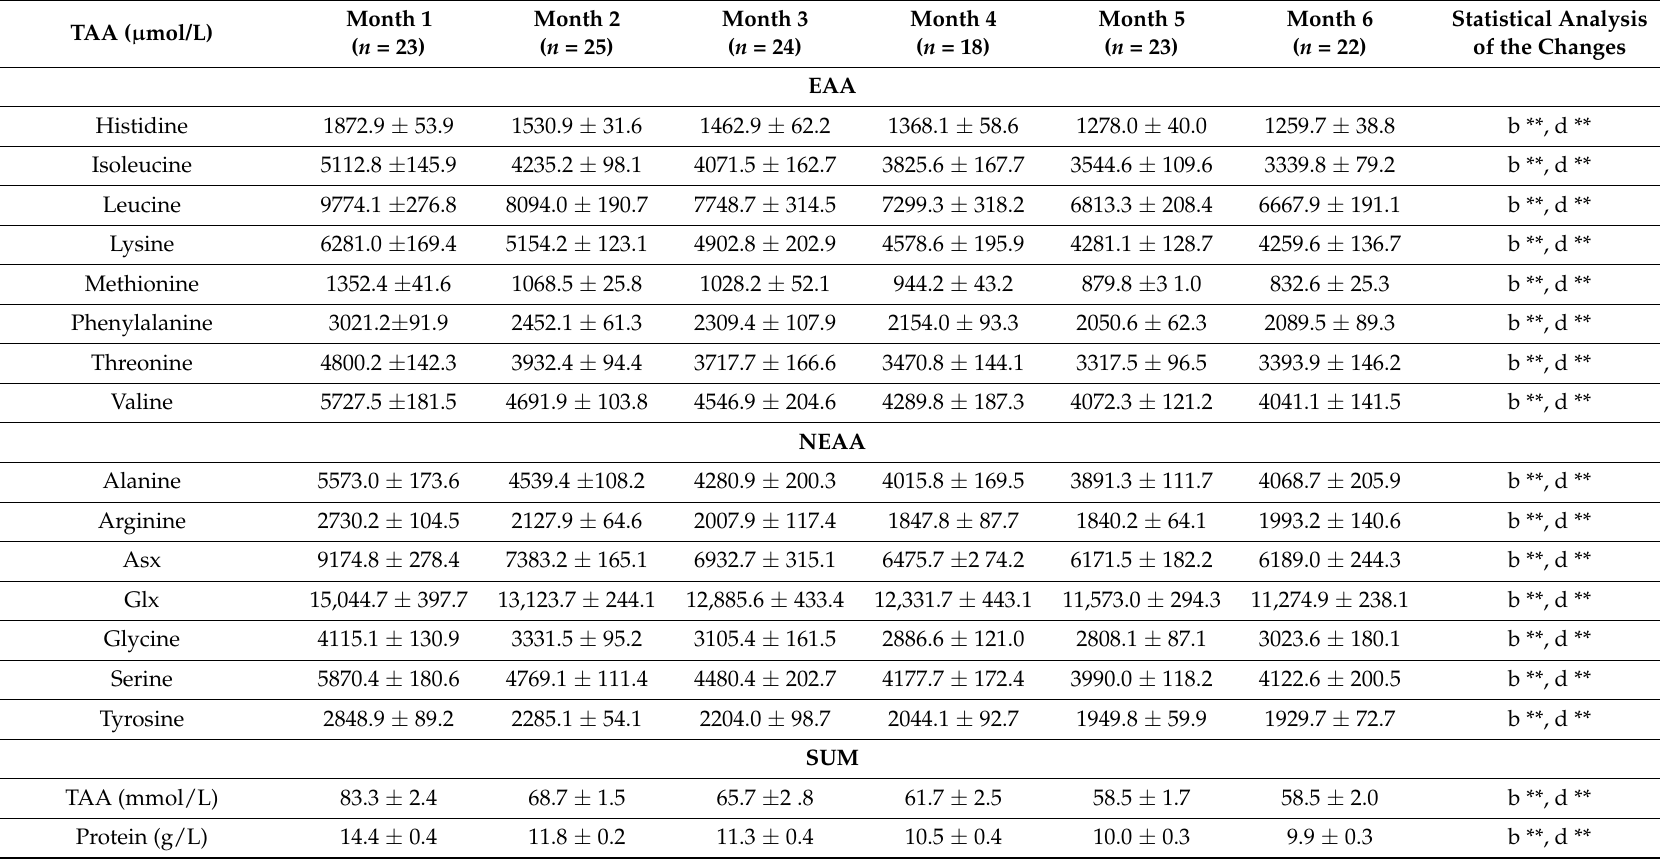
Table 3. Total amino acid levels in human milk during months 1–6 of